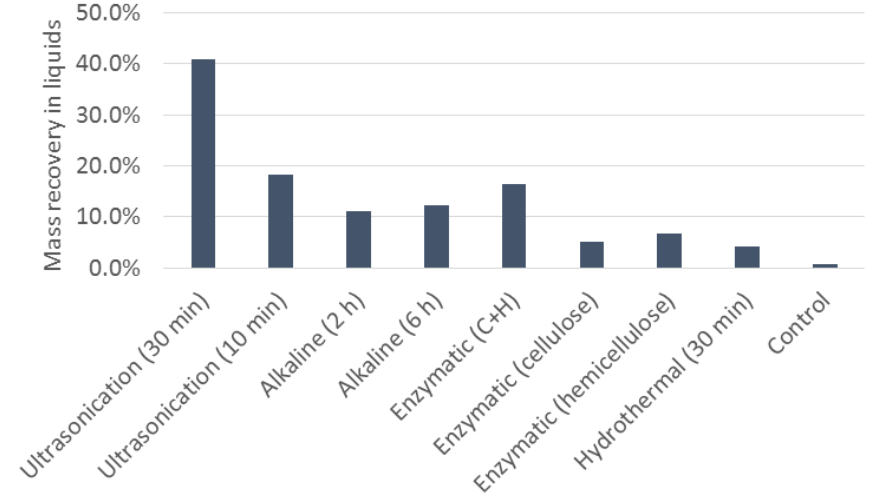
Figure 3. Comparison of several cell disruption techniques in the process of fractionation of a local Synechococcus strain.